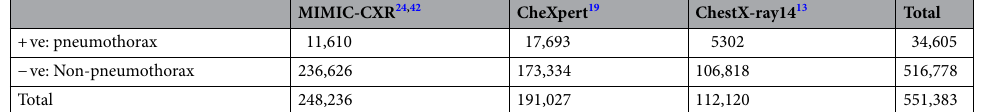
Table 2. A summary of chest X-ray images in the Dataset 2 through combination of three public datasets.